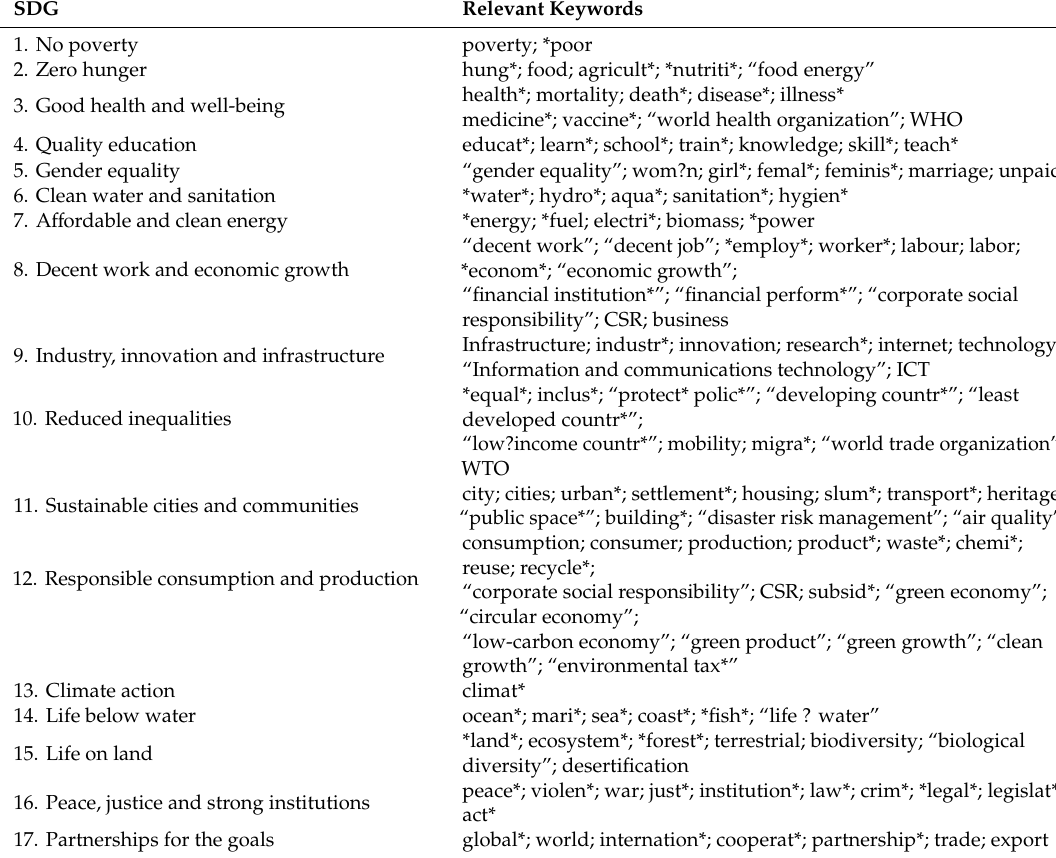
Table 1. The guidelines for categorizing SDG-related